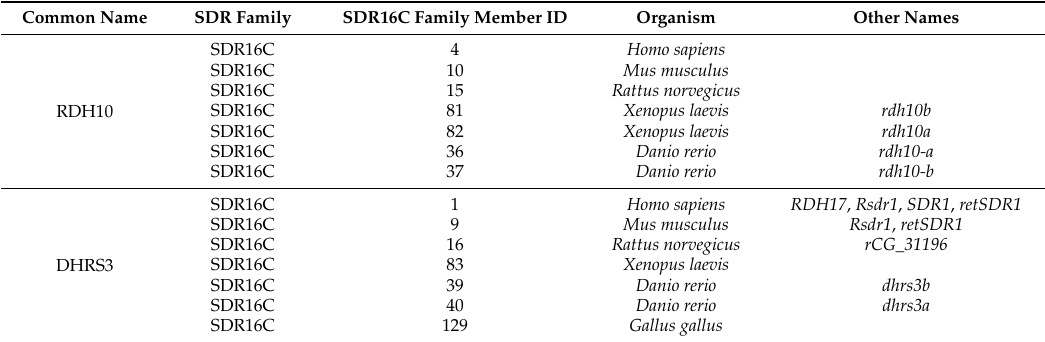
Table 1. Nomeclature of SDR16C enzymes RDH10 and DHRS3 from model organisms. For complete list of SDR enzymes see: